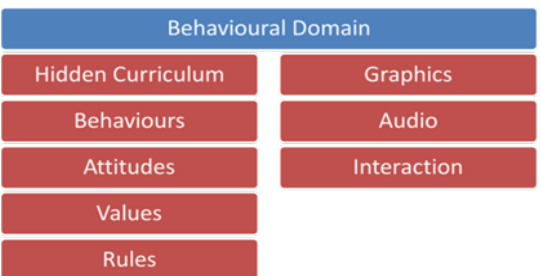
Figure 3. Behavioural domain relationship with digital game